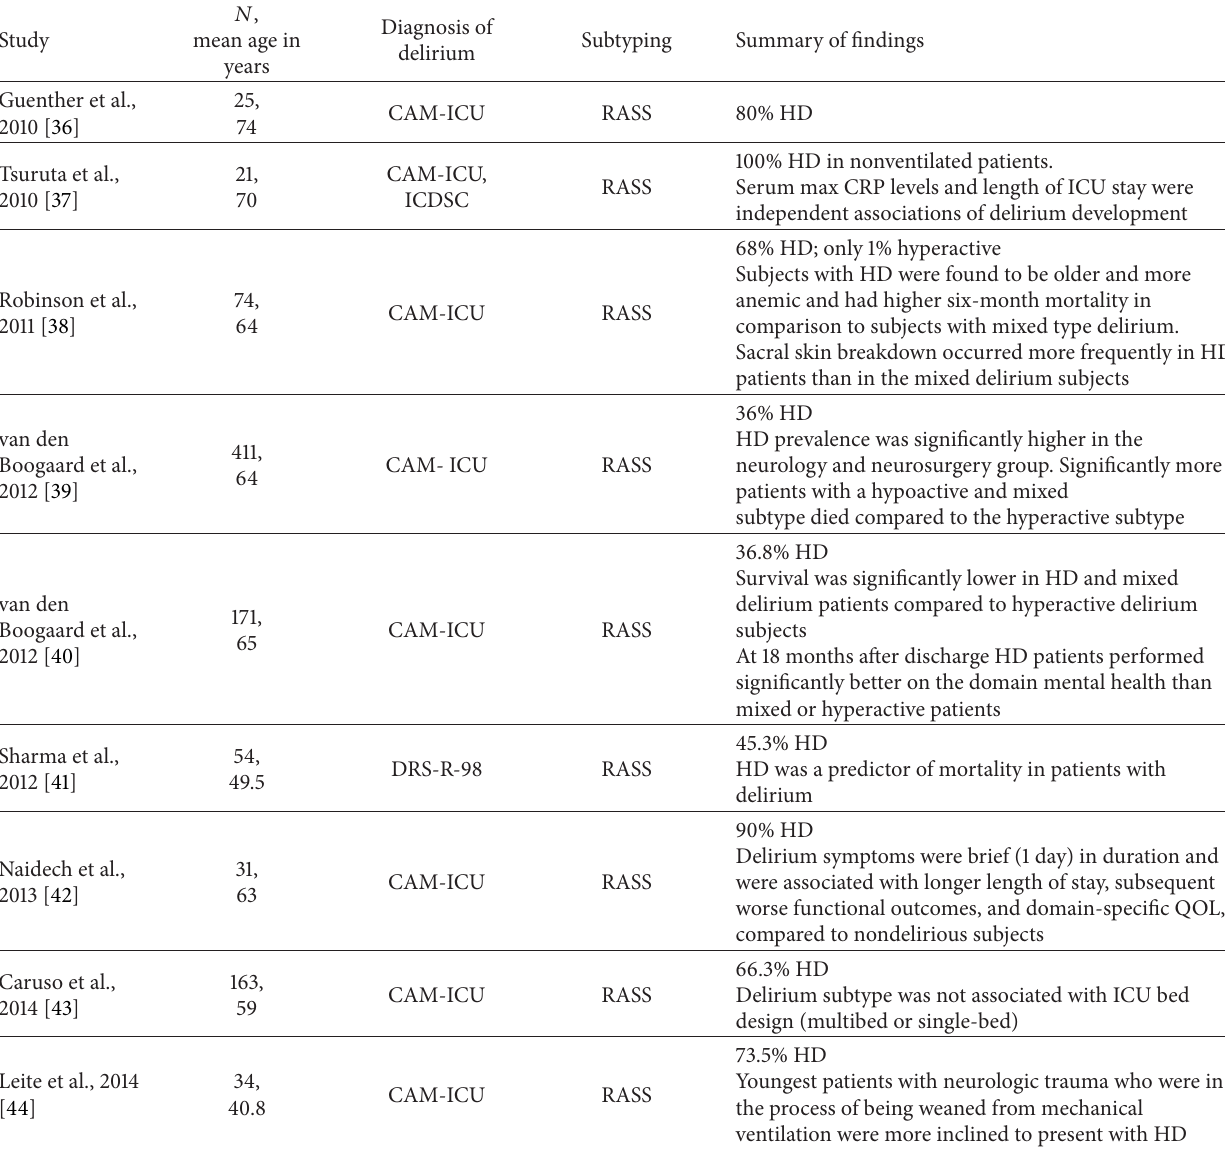
Table 4: HD in the Intensive Care